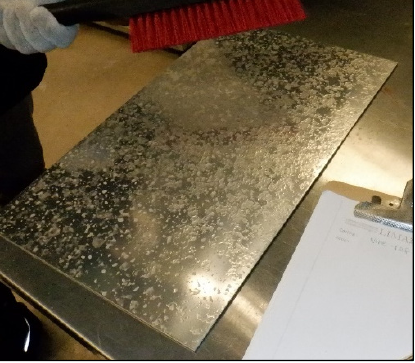
Figure 5. Low-intensity freezing rain over aluminum reference plate.